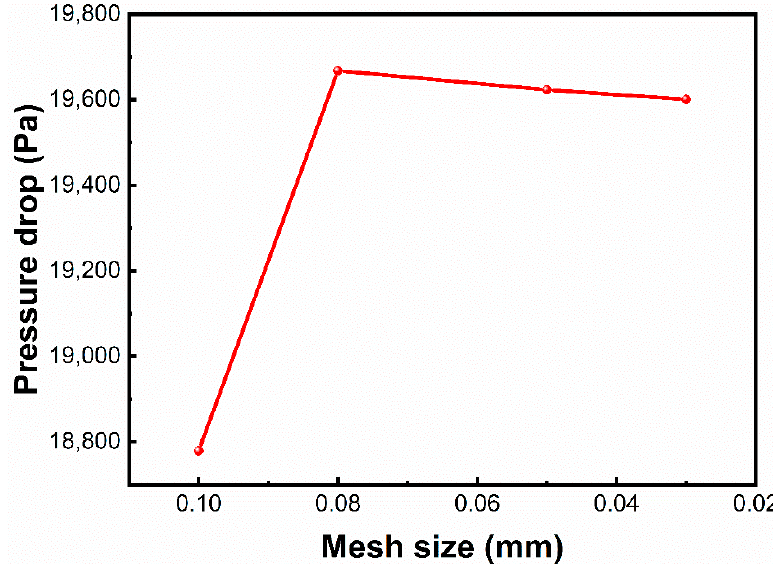
Figure 3. Pressure drop across the static mixers obtained using four different mesh sizes for grid sensitivity analysis.